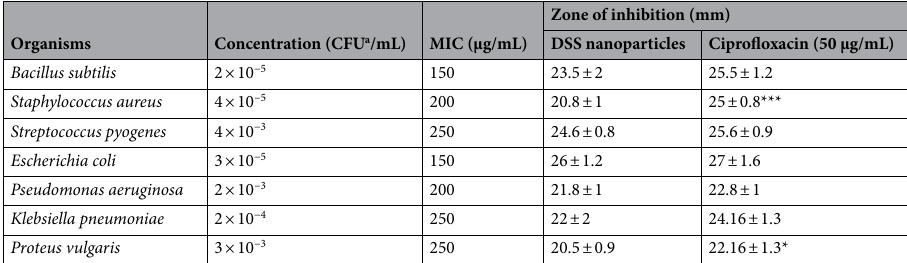
Table 2. Antibacterial study of dextran sulfate sodium (DSS) nanoparticles of batch 3. Each value is the mean of 6 batches with standard deviation. The statistical analyses were done using the Prism 9, Graph Pad Instat software system, USA. The test values were compared with the standard drug values using Dunnet’s post hoc test. ***Extremely significant at p ≤ 0.001when compared to DSS nanoparticles; *significant at p ≤ 0.01 when compared to DSS nanoparticles. a CFU colony forming